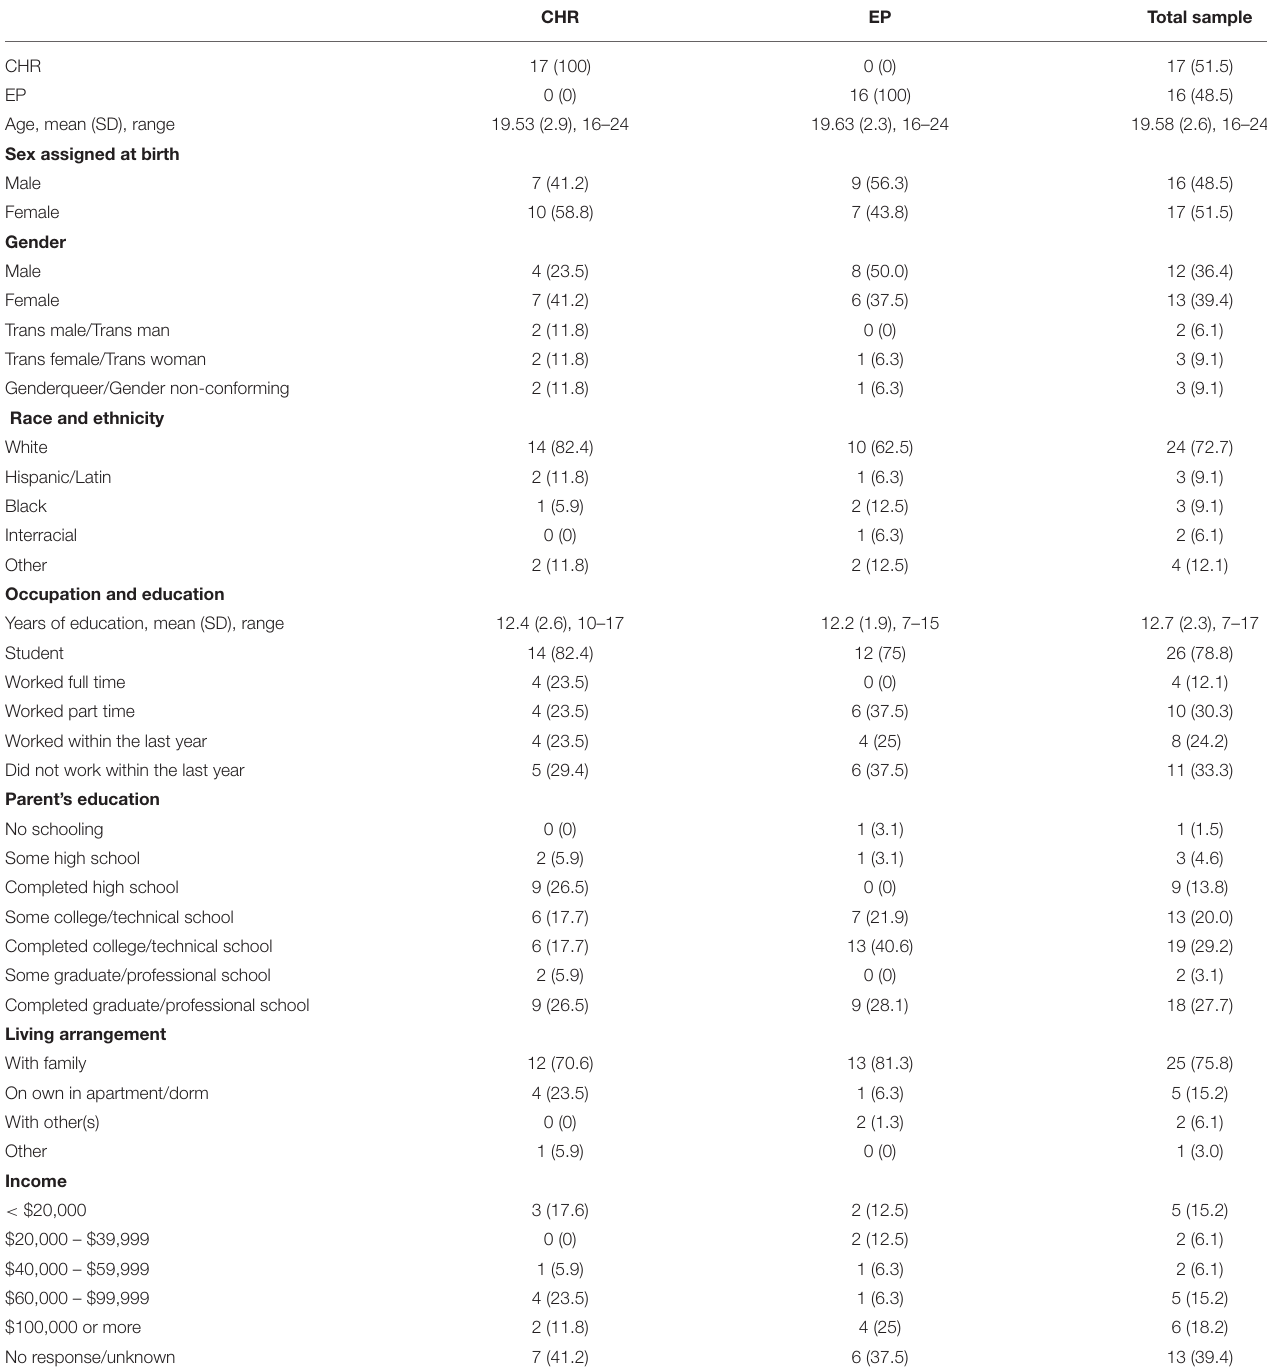
TABLE 1 | Demographic characteristics for participants with N (%) reported unless otherwise